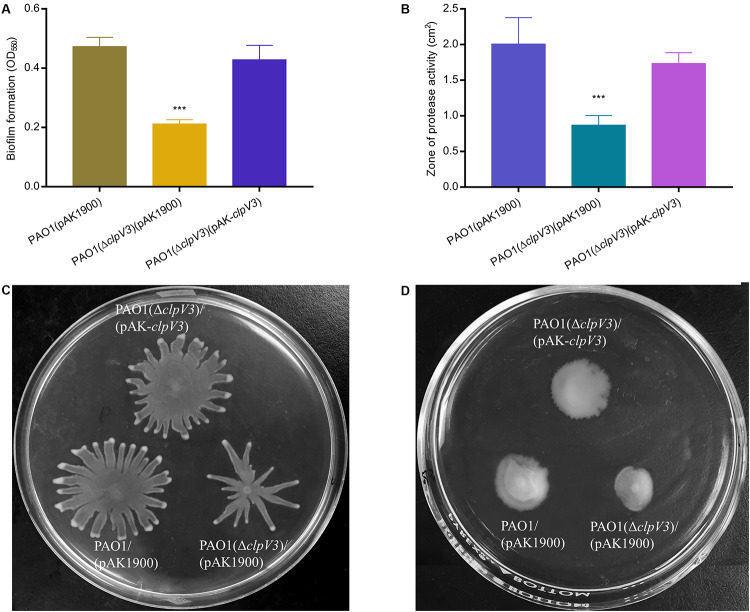
Inactivation of H3-T6SS in P. aeruginosa alters numerous phenotypes. (A) Biofilm formation was evaluated in 96-well microtiter plates and our results showed that biofilm formation was significantly decreased in PAO1(ΔclpV3) compared with in PAO1 or the complementation strain. (B) PAO1(ΔclpV3) showed smaller proteolytic zone than PAO1, which indicated that deletion of clpV3 leads to producing less protease production. (C,D) Inactivation of H3-T6SS resulted in altered swarming motility and reduced swimming motility. The experiment was independently performed three times. Unpaired Student’s t-test was used to analyze the data. Error bars indicate standard deviations. ***p < 0.001.